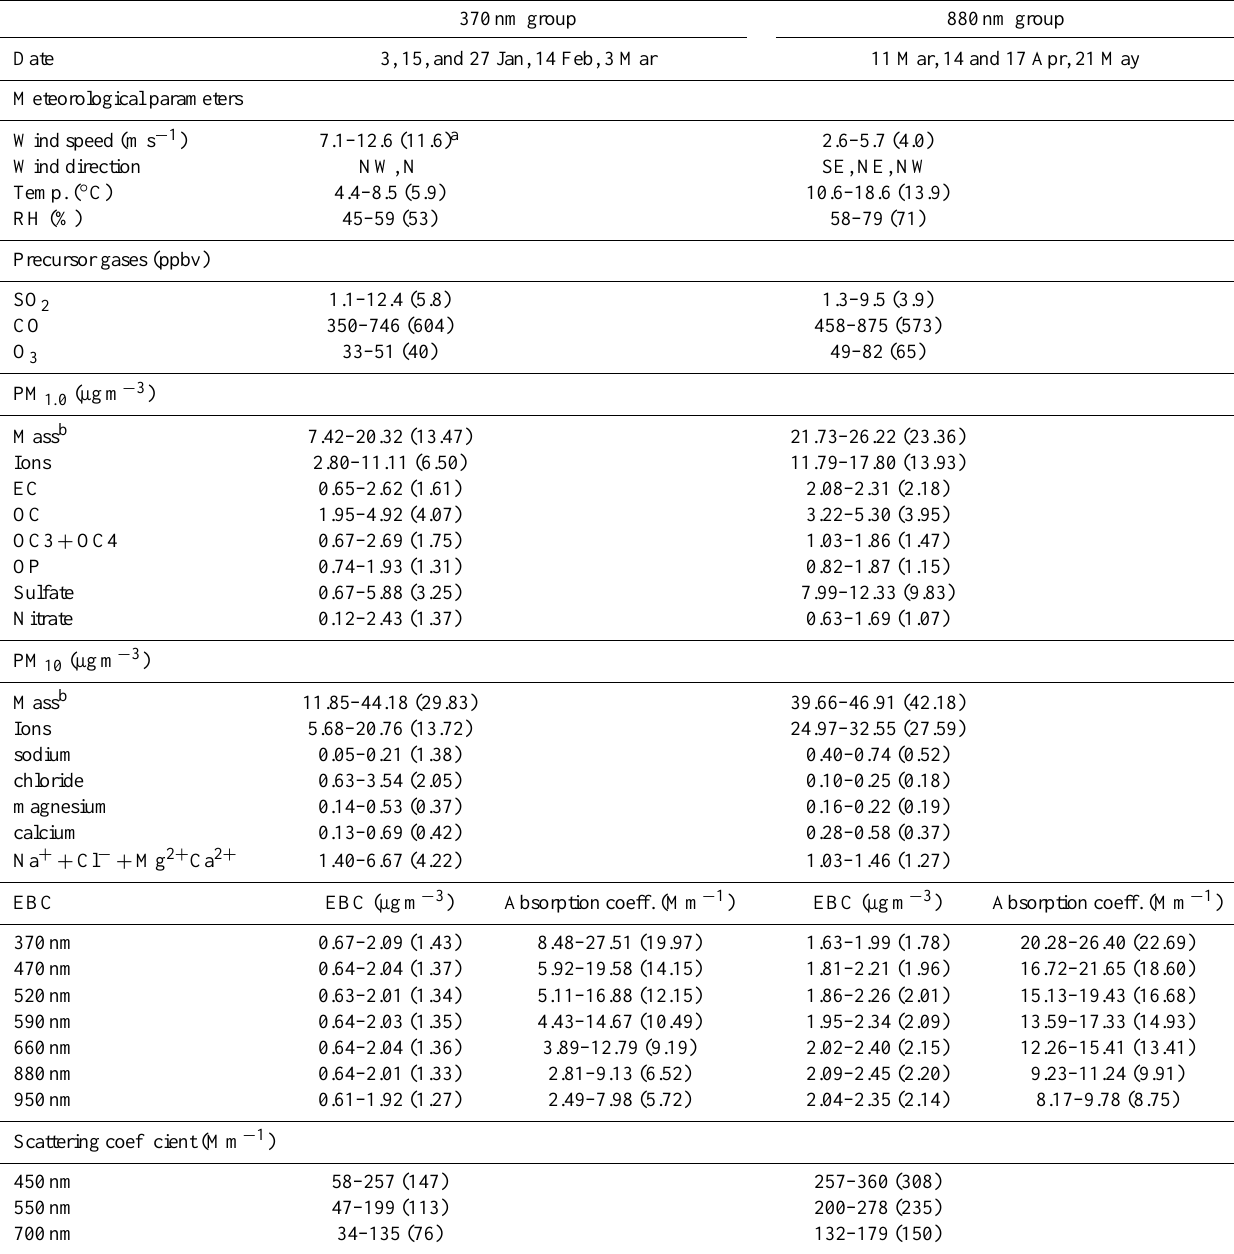
Table 1. Comparison of the 370nm group and the 880nm